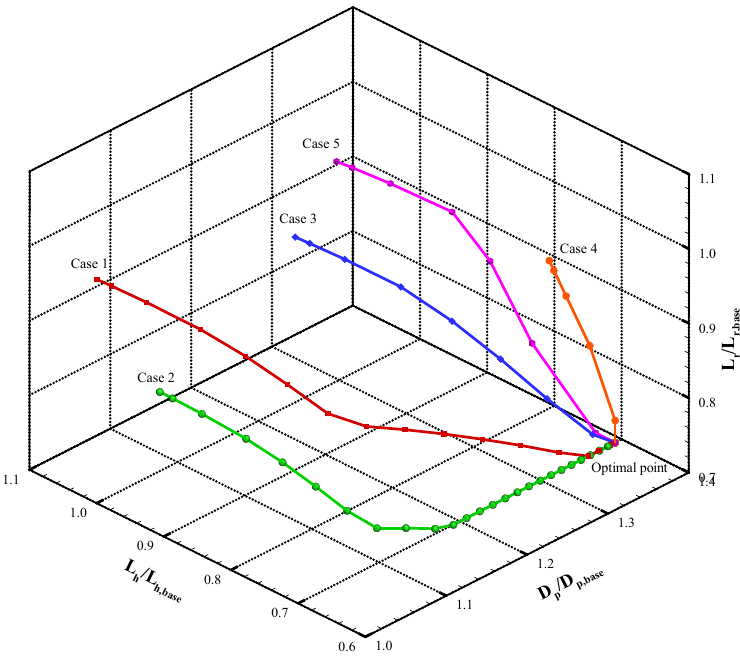
Figure 5. Robustness of the VSCGM method with different initial guesses. Table 6. Given guesses and optimal points.